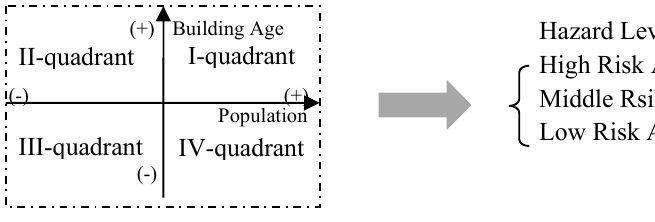
Figure 3. Software operation example.